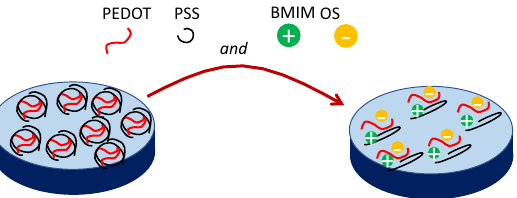
Figure 1. Schematic representation of molecular interaction between the IL BMIM:OS and the PEDOT:PSS, where the PEDOT:PSS is decoupled into PSS − and PEDOT + with the ions BMIM + and OS - . Large-scale conducting domains are thus